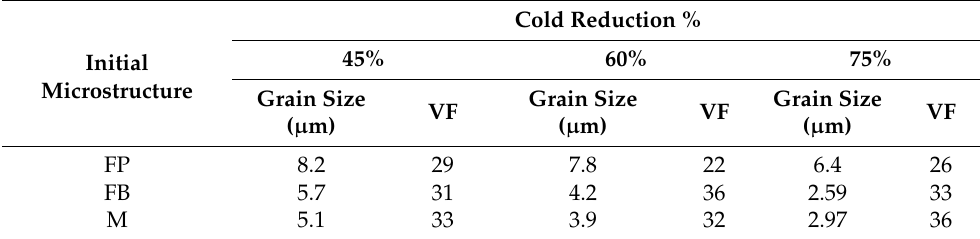
Table 3. Comparison of the ferrite grain sizes and martensite volume fractions with respect to cold reductions and initial microstructures after inter-critical